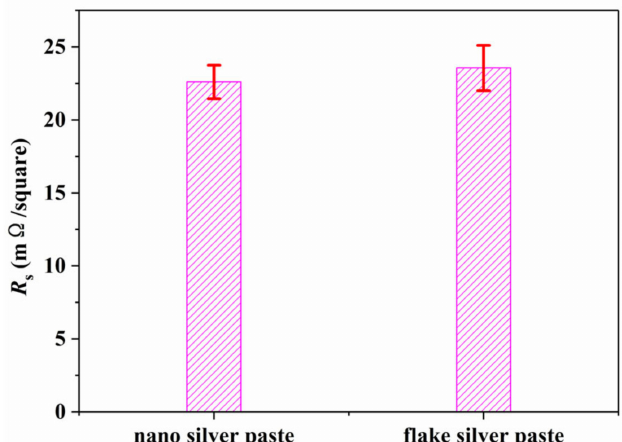
Figure 8. The R s of cured nano silver paste and flake silver